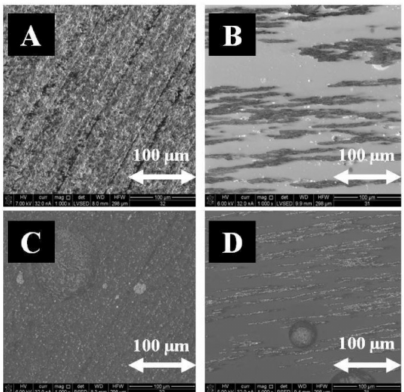
Figure 4. Microstructure of epoxy resin (Ep 5) and Fe 3 O 4 composite polymerized without the application of CMF ( A , C ) and in CMF of B = 0.5 T ( B , D ), image of secondary electrons SE ( A , B ) and image of backscattered electrons BSE ( C , D ), magnification 1000 × .